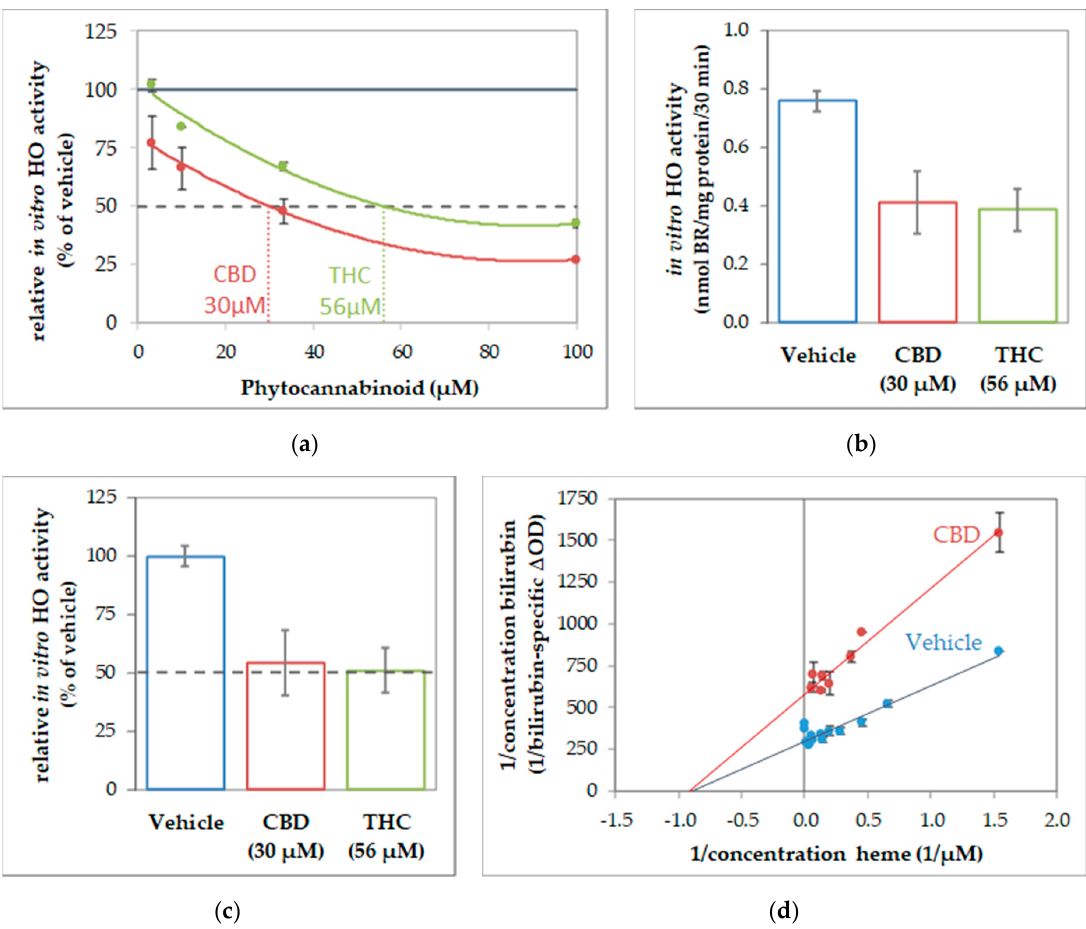
Figure 3. Cannabidiol acts as a non-competitive inhibitor of heme oxygenase. Determination of inhibitory concentration (IC) 50 of cannabinoids (CBs) inhibiting in-vitro heme oxygenase (HO) activity of J774A.1 cells. ( a ) Dilution series of cannabinoids (cannabidiol (CBD), red; tetrahydrocannabinol (THC), green) were used to inhibit the in-vitro HO activity of cell homogenate (J774A.1 cells) and calculated in % of the vehicle-treated control. The black dotted line indicate 50% inhibition. Values were obtained from duplicates and plotted against the input concentration of CBs. By polynomial analyses, the IC 50 was calculated and the respective concentrations determined. ( b , c ) Verification of IC 50 . Determination of HO activity was performed in the presence of CBs at the calculated concentrations and results are shown ( b ) in nmol bilirubin (BR)/mg of protein/30 min and ( c ) in % of the vehicle control (set to 100%). The black dotted line indicates 50% inhibition. ( d ) The inhibitory characteristic of CBD was determined using a dilution series of heme in the presence of CBD (30 µM; red dots) or with vehicle (blue dots). The obtained values were plotted reciprocally. The regression analyses revealed a non-competitive inhibition mode of CBD on HO activity in cell homogenates. All experiments were performed once ( n = 1) using duplicates/triplicates. Data are given as means ± SD.